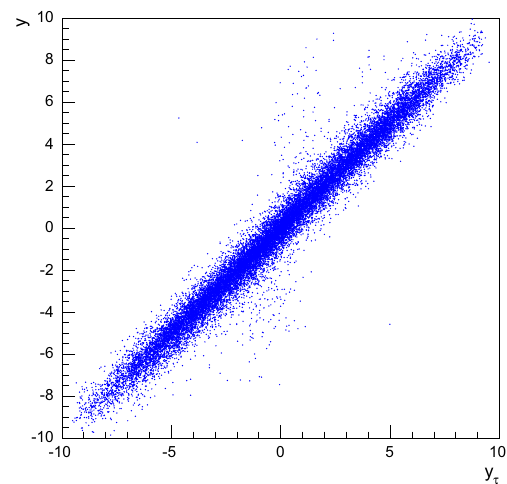
Fig. 14 Correlationbetweenrapidity, y ,andtheequivalentspace–time rapidity, y τ , for all hadrons in 100 inelastic nondiffractive pp events at √ s = 13